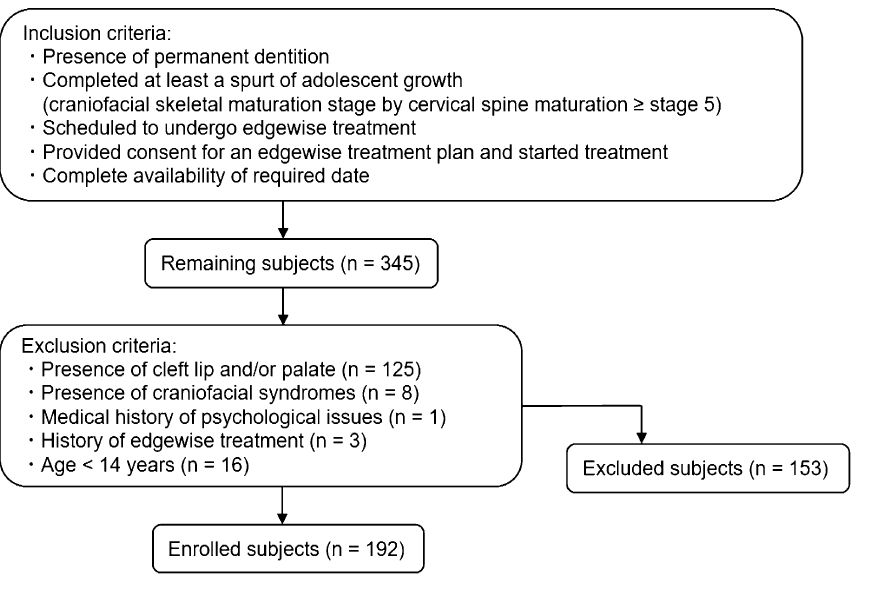
Figure 1. Flowchart of participant